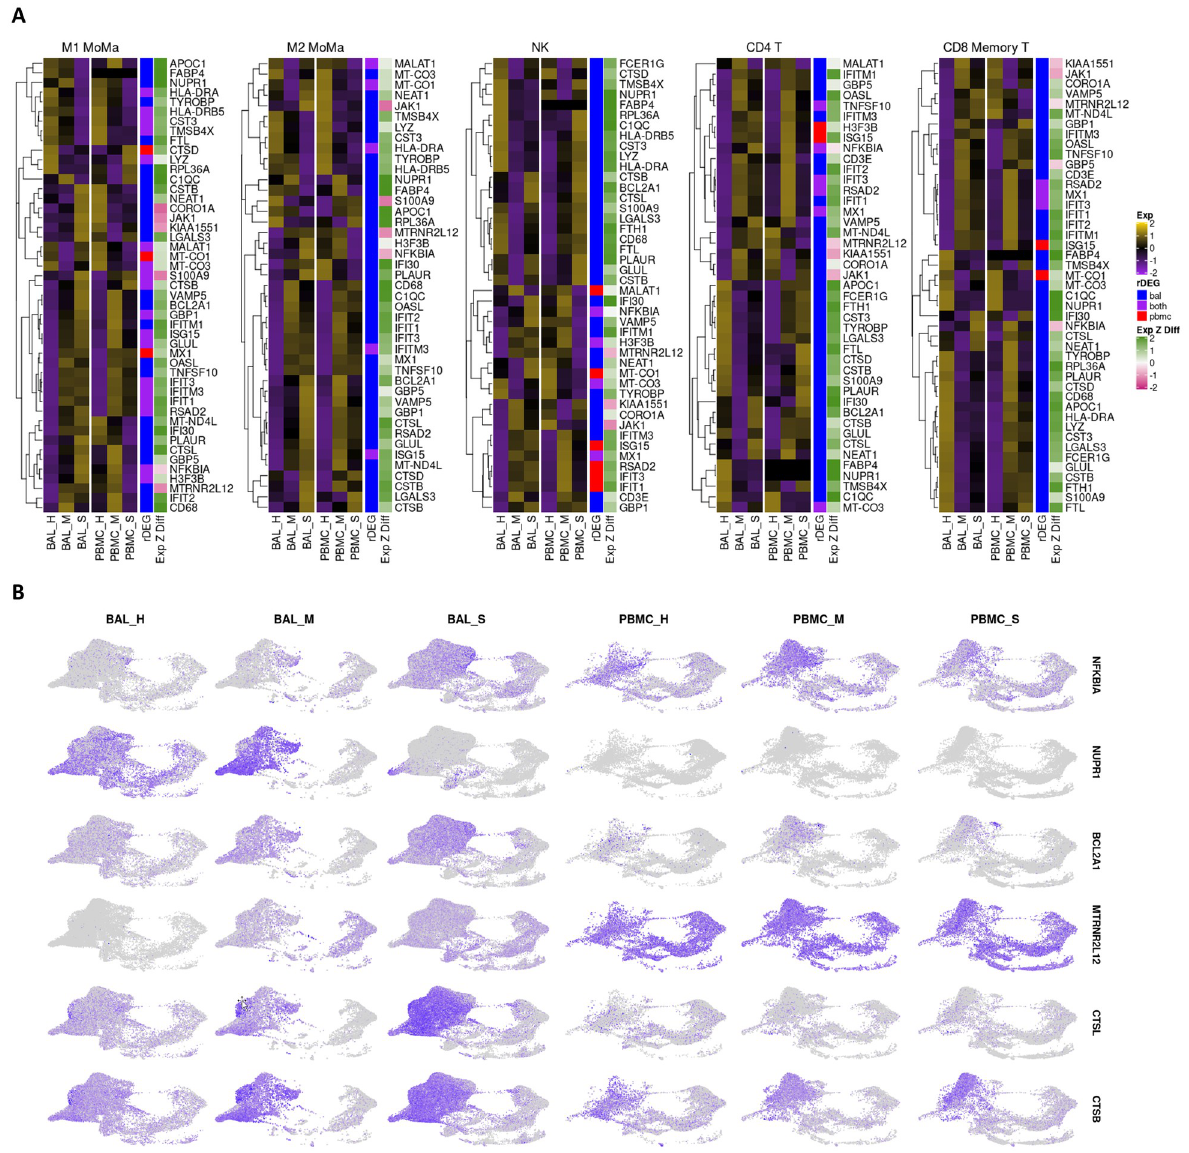
Fig 3. rDEG expression in most abundant cell types highlights differential immune regulation between mild and severe patients in both BAL and PBMC cohorts. A . Heatmaps visualizing rDEGs within each of the top five most abundant cell types in our dataset (generated using the ComplexHeatmap R package). For each cell type, the full rDEG list was filtered via the same p-values (p < 10e-7 for BAL, p < .05 for PBMC) and only rDEGs that are differentially expressed below these thresholds for either BAL or PBMC are included in the plot. Expression levels are normalized separately for each cohort. The first sidebar indicates which cohort the particular gene passed the rDEG threshold for, while the second sidebar indicates the ratio of expression of the particular gene between BAL and PBMC with green (positive values) indicating higher expression levels detected in BAL. Full p-value tables are provided in S7 Table. B . Visualization of select rDEGs representing pathways outside of the main interferon activated gene group that are relevant to disease. These genes are visualized separately for each cohort and condition using the sample UMAP projection of cell types from Fig 1. Each gene shows cell type, cohort, and condition specific differences in localization across the